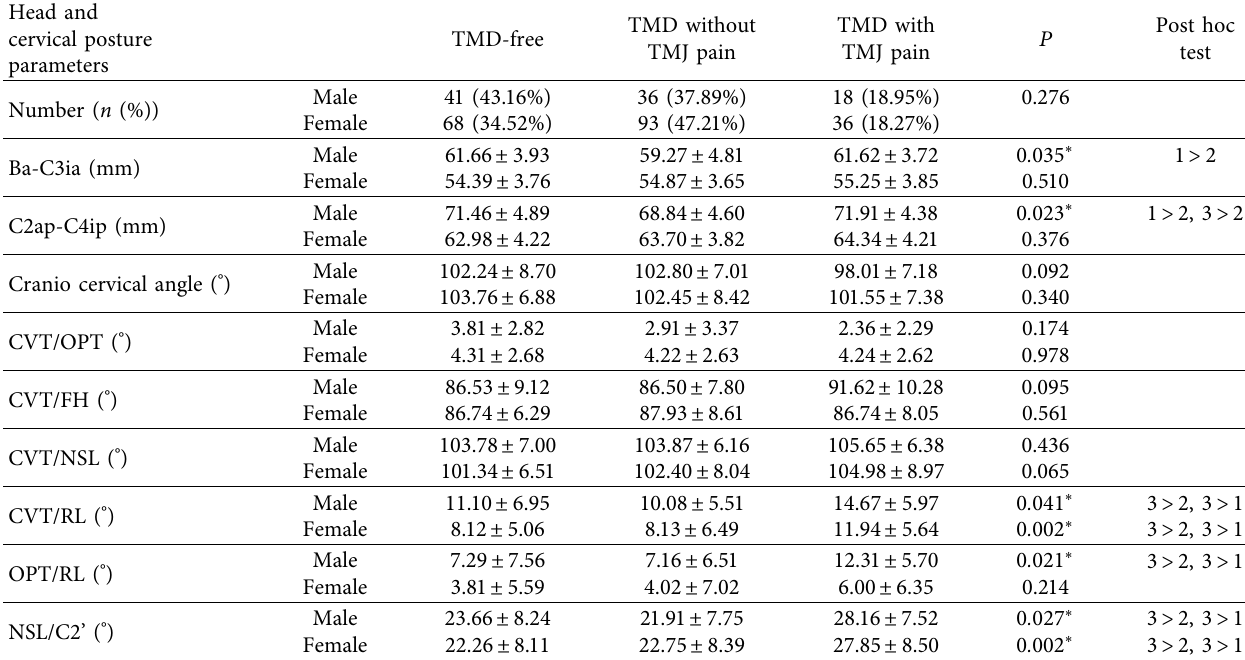
Table 4: Head and cervical posture parameters of TMD-free patients, TMD patients without TMJ pain, and TMD patients with TMJ pain in the adult